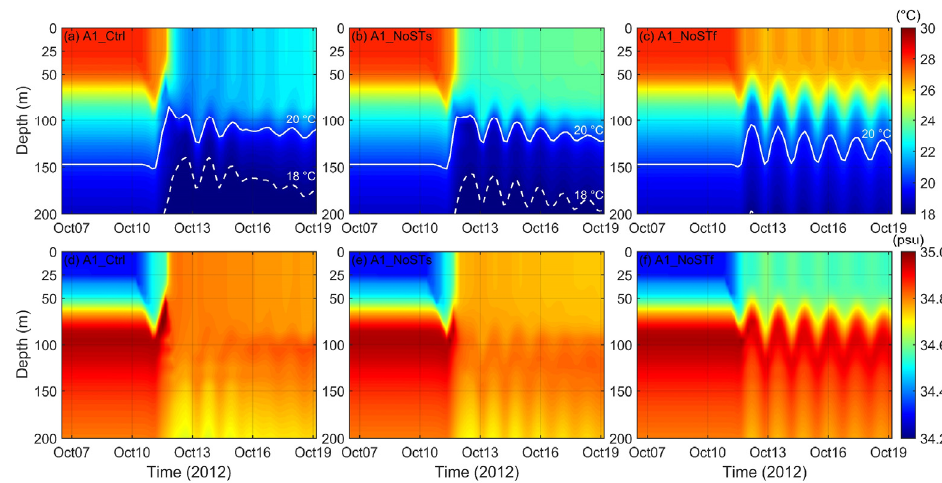
Figure 12. Temporal evolution of the temperature and salinity profiles in the 3DPWP experiments. ( a ) Temperature evolution in Experiment A1_Ctrl; ( b ) temperature evolution in Experiment A1_NoSTs; ( c ) temperature evolution in Experiment A1_NoSTf; ( d ) salinity evolution in Experiment A1_Ctrl; ( e ) salinity evolution in Experiment A1_NoSTs; and ( f ) salinity evolution in Experiment A1_NoSTf. The white solid lines represent the 20 °C isotherm. The white dotted lines represent the 18 °C isotherm.